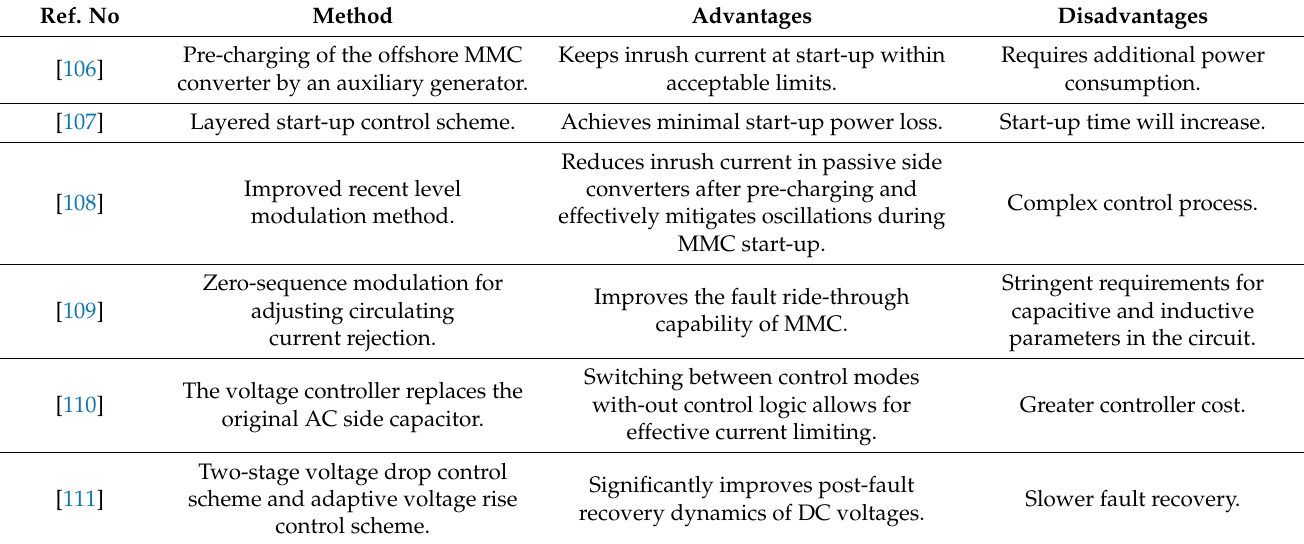
Table 5. MMC converter control methods for offshore wind